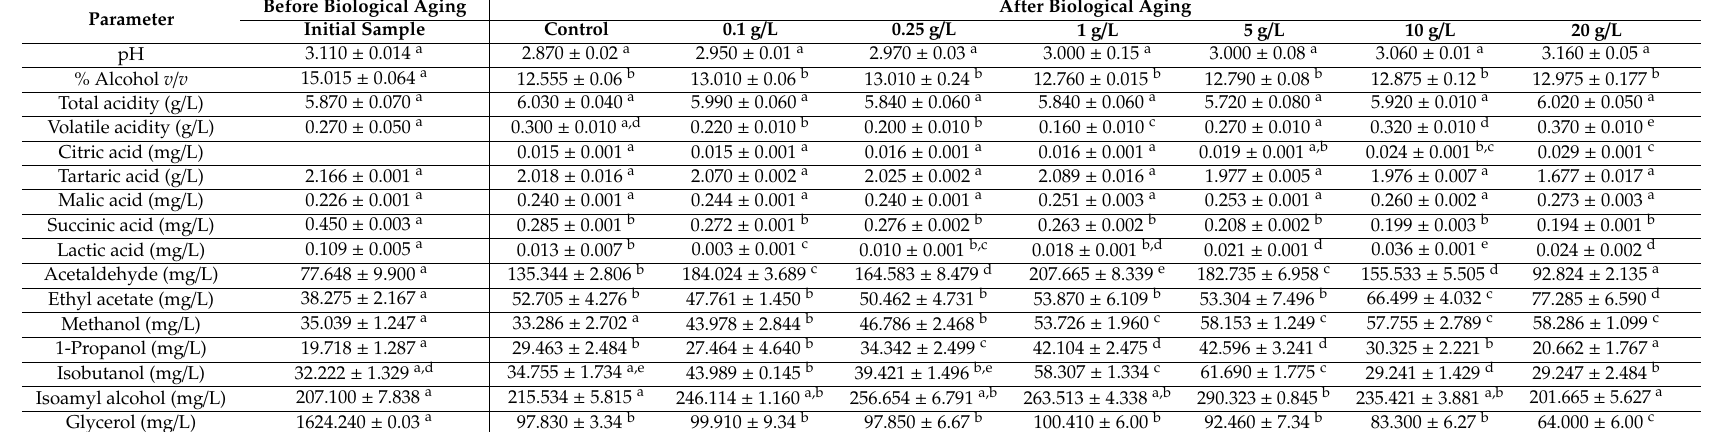
Table 1. E ff ect of bee pollen on the physicochemical parameters and the total organic acids and major volatile compounds